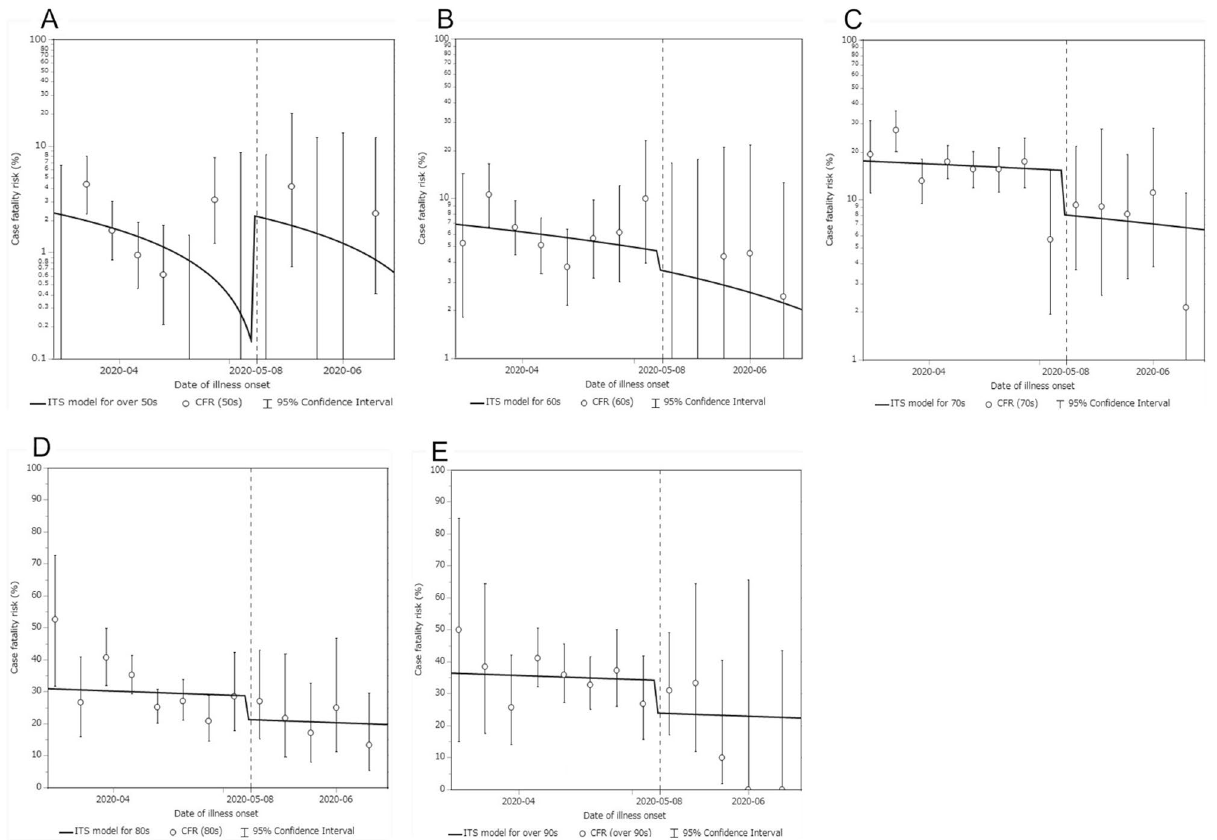
Figure 3. Case fatality risk of COVID-19 by age group from 1 April to 15 June 2020 in Japan. The vertical axis represents the case fatality risk. The horizontal axis represents the date of illness onset. The dotted line is the date on which the restriction on outpatient attendances was cancelled (i.e., people no longer had to wait 4 days from the onset of fever). The circular dots represent the empirically observed case fatality risk for every seven days, with error bars representing the 95% confidence intervals computed using Wilson’s score method. The upper left panel ( A ) shows the case fatality risk among cases aged 50–59 years, the upper middle panel ( B ) those aged 60–69 years, the upper right panel ( C ) those aged 70–79 years, the lower left panel ( D ) those aged 80–89 years, and the lower right panel ( E ) those aged 90 years and